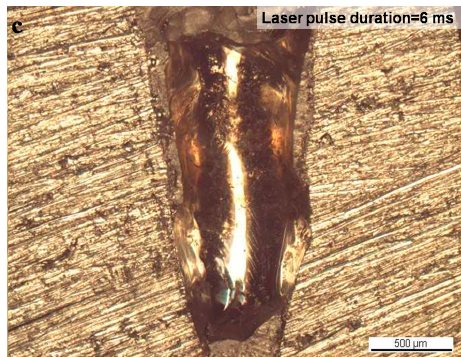
Figure 7. Optical microscopy images of cross-sections of laser welds conducted with discrete pulses, power = 5.5 kW, frequency = 1 Hz, in-depth focusing of 2.5 mm: ( a ) weld with reduced porosity and spilled material; ( b ) weld with large pore; and ( c ) keyhole devoid of metal.